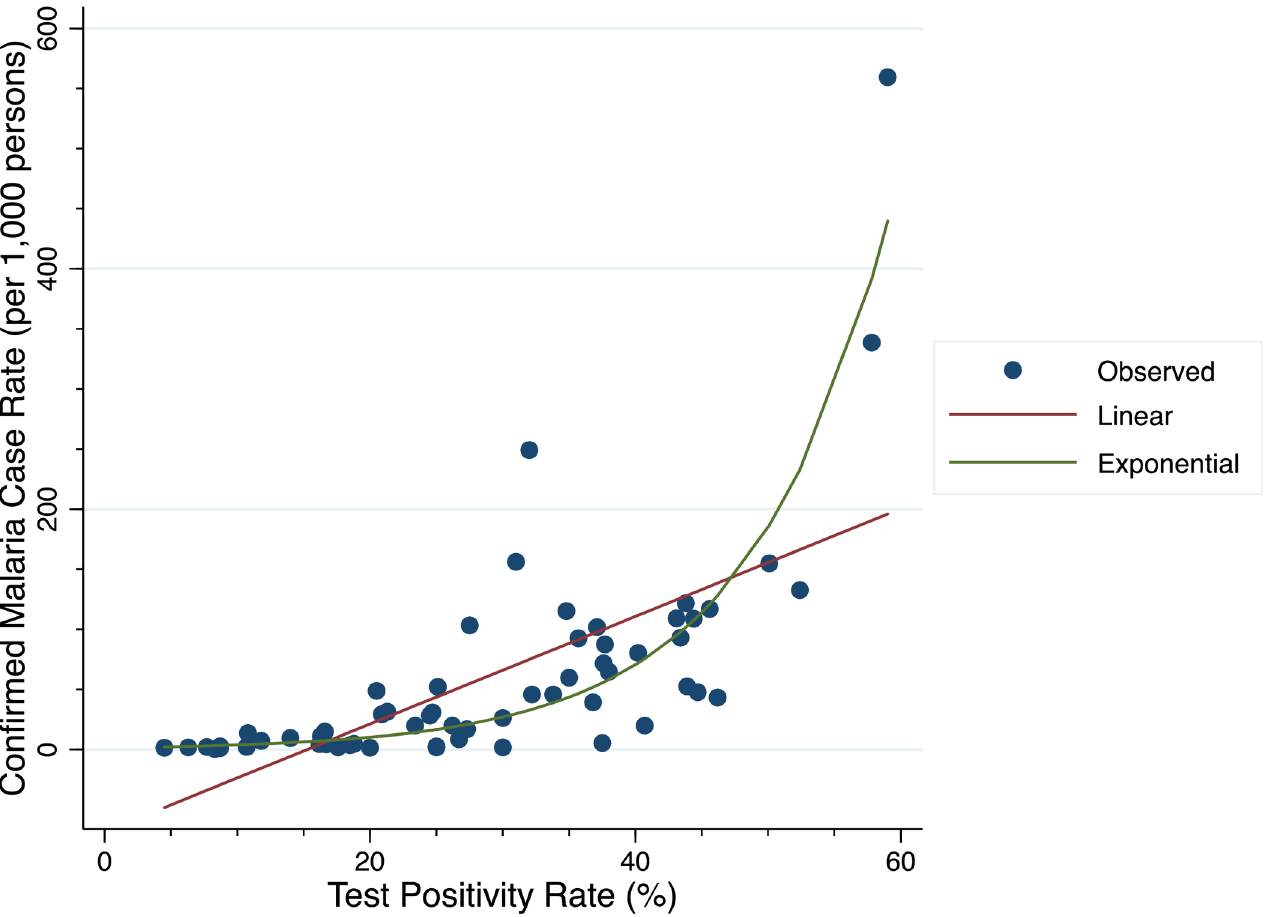
Fig 1. Linear (red) and exponential (green) models of the relationship between confirmed malaria case rate and test positivity rate at 6-month measurement intervals.